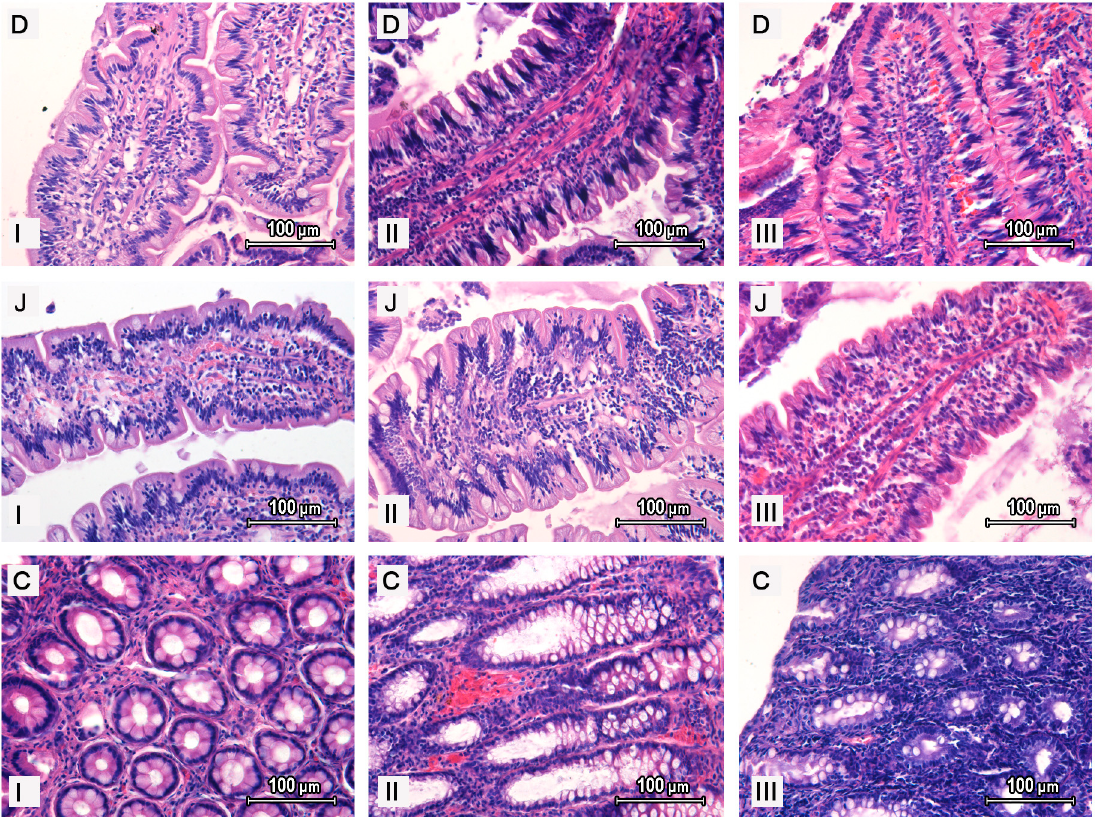
Figure 2. Histopathological examination of the duodenum ( D ), jejunum ( J ) and descending colon ( C ) of dogs with mild ( I ), moderate ( II ) and severe ( III ) IBD.